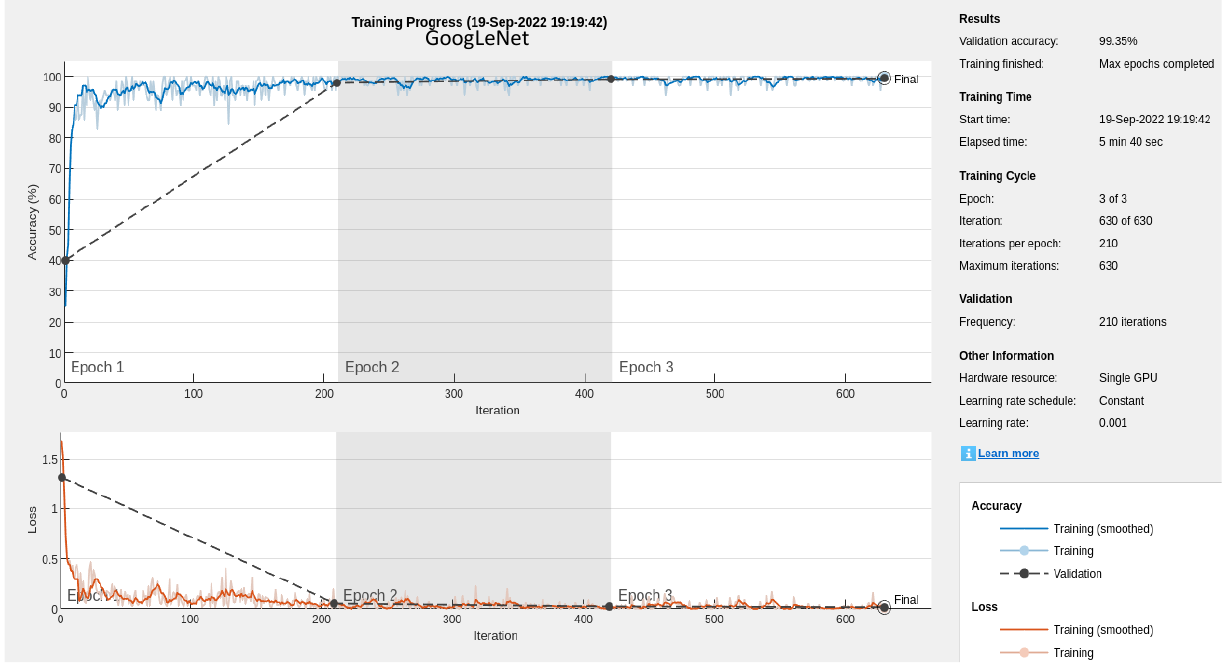
Figure 6. Accuracy and loss of training progress in the GoogLeNet transfer learning.